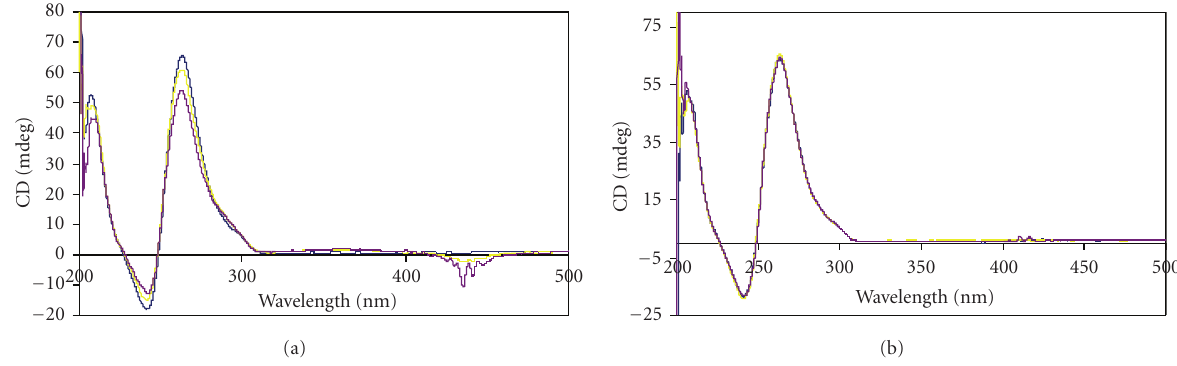
Figure 2: (a) CD spectra for the 27Bcl2 mid promoter sequence, wavelength in nm is plotted on x -axis, and Ellipticity, θ , is plotted on the y -axis in mdeg. The 5 × 10 − 6 M quadruplex DNA is considered for each CD experiment. CD spectra are recorded at 1 : 2 and 1 : 4 quadruplex DNA: TMPyP4 stoichiometry. Each spectrum is recorded thrice, and the average of the three runs is considered. (b) CD spectra for the C-myc sequence, wavelength in nm is plotted on x -axis and Ellipticity, θ , is plotted on the y -axis in mdeg. The 5 × 10 − 6 M quadruplex DNA is considered for each CD experiment. CD spectra are recorded at 1 : 2 and 1 : 4 quadruplex DNA: TMPyP4 stoichiometry. Each spectrum is recorded thrice, and the average of the three runs is considered.